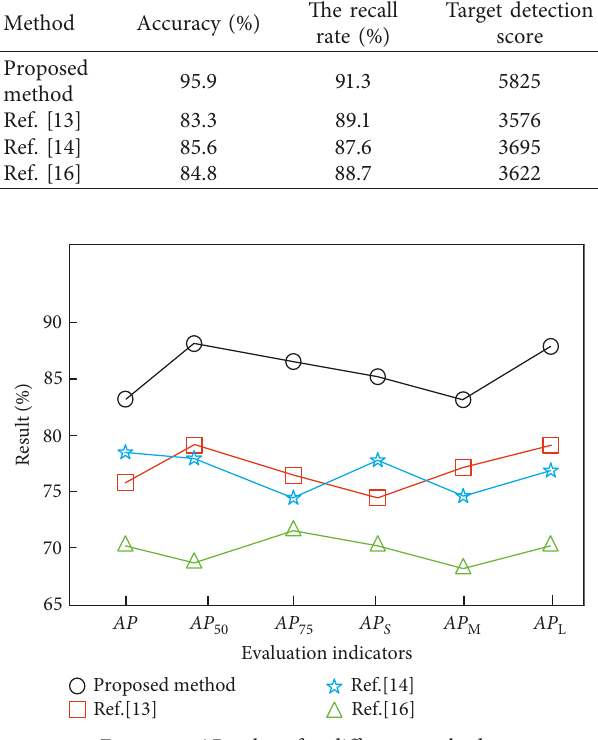
Figure 7: AP values for different